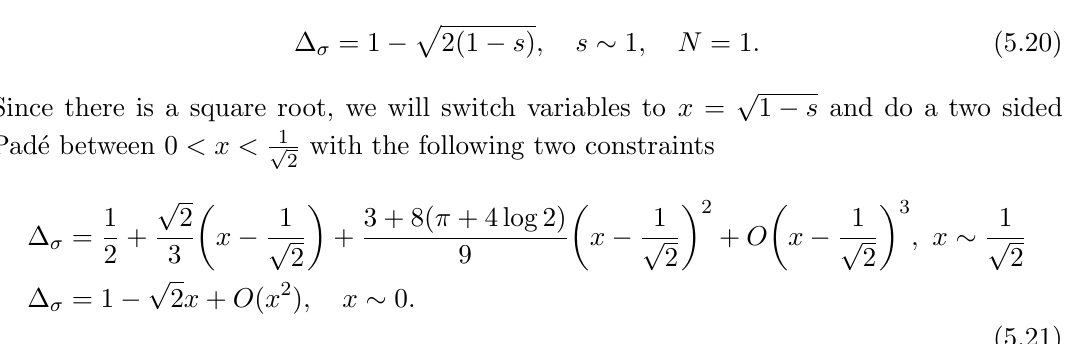
Table 1 . The numerical results for (cid:1) (cid:27) = 1 (cid:0) 1 =(cid:23) from our Pad(cid:19)e approximants and the available Monte Carlo results for various values of s . As N grows, the results approach the prediction of the large N expansion, which gives (cid:1) (cid:27) = s + O(1 =N ). dimension of (cid:27) near s = 1 for the case of long range Ising was found in [56] to